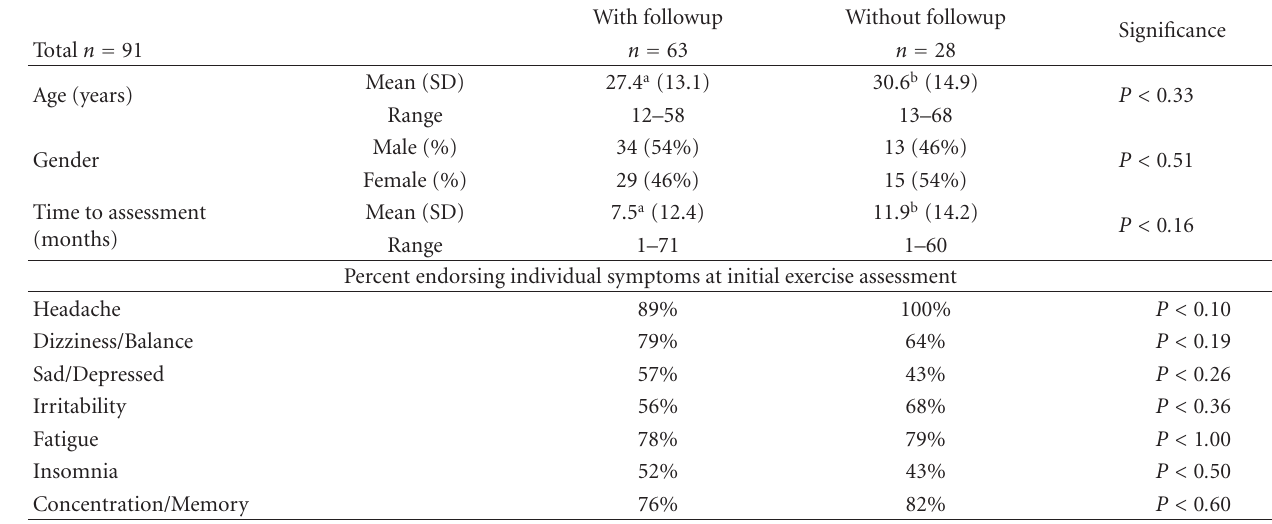
Table 2: Comparison of patients with followup information ( n = 63) to patients without followup information ( n =